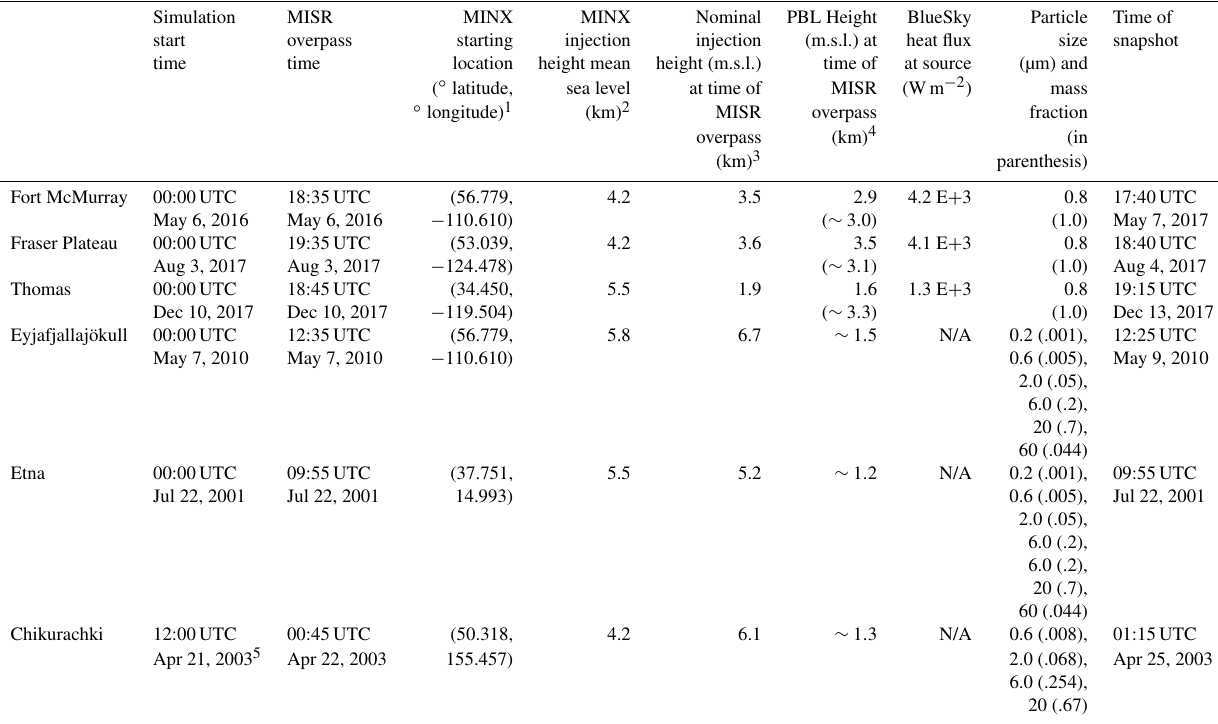
Table 1. (1) Wildfire cases have multiple source locations, but are shown as one representative location here. (2) Wildfire source locations also have their own injection heights determined by MINX. The highest injection height is identified on this table. Vertical resolution for the MINX injection height is around 250m. The height listed here is the highest plume height recorded for each source. (3) The nominal plume- rise height is given at the time of MISR overpass, for direct comparison with the MINX injection height. Figure 3 shows nominal plume rise and up-to-date meteorology at the time that the snapshot was taken for each case. (4) All PBL heights marked with ∼ are approximated from the nearest sounding location. Heights without parentheses or ∼ were derived from the meteorological data at the time and location of the MISR overpass. The heights in parenthesis are above ground level and not above the geoid. (5) The Chikurachki eruption simulation was started the day before the MISR overpass, because the overpass occurred close to the usual 00:00UTC initialization. All other simulations had approximately 10 or more hours between initialization and the first